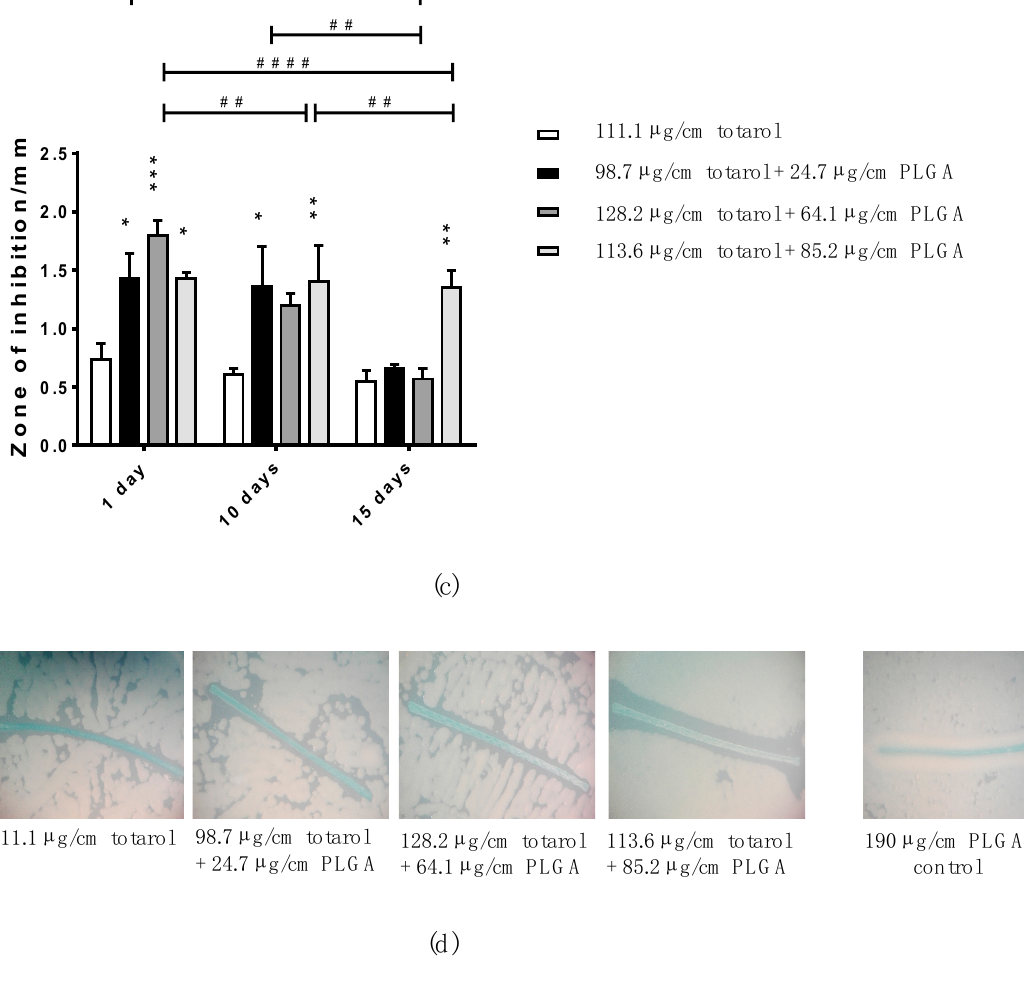
Figure 5. ( a ) Differences in the zones of inhibition of multifilament sutures coated in stock solutions made with 250 mg totarol and different amounts of PLGA at days 1, 10, and 15 of the ADT ( n = 3); ( b ) Representative images of the sutures coated in the four stock solutions and their zones of inhibition after 15 days. As the negative control, a PLGA-only-coated suture is shown; ( c ) Bar graph representing the characteristics of the zones of inhibition caused by multifilament suture material coated with a 100 mg/mL totarol stock solution combined with varying amounts of PLGA at days 1, 10, and 15 of the ADT ( n = 3); ( d ) Representative images of the different sutures and their zones of inhibition after 15 days. As the negative control, a PLGA-only-coated suture is shown. Data are given as means with SEM. Two-way RM ANOVA followed by Tukey’s multiple comparisons test was used to identify significant differences. Asterisks (* p < 0.05, ** p < 0.01, *** p < 0.001, and **** p < 0.0001) indicate statistical significances between the diverse coatings and the control (totarol coating without PLGA). Hashes ( # p < 0.05, ## p < 0.01, ### p < 0.001, and #### p < 0.0001) indicate statistical significance between the equal coating solutions at the various time points.